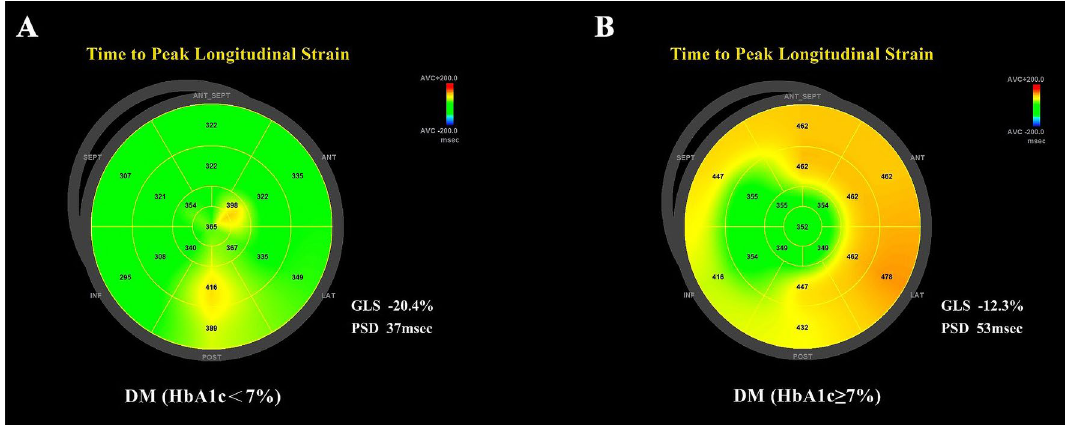
Figure 1. Bullseye plots of time to peak longitudinal strain are shown in two T2DM patients using EchoPAC workstation 2DSTE analysis. The endocardium of the LV was tracked point by point in the apical four-chamber, apical three-chamber and apical two-chamber views. After 17 segments of the LV were successfully tracked, GLS and LV PSD were automatically abtained. A patient with controlled blood glucose (HbA1c < 7%) displayed an LV GLS of 20.4% (absolute value) and LV PSD of 37 ms ( A ). More pronounced LV GLS of 12.3% (absolute value) and LV PSD of 72 ms were observed in a DM patient with uncontrolled blood glucose (HbA1c ≥ 7%) ( B